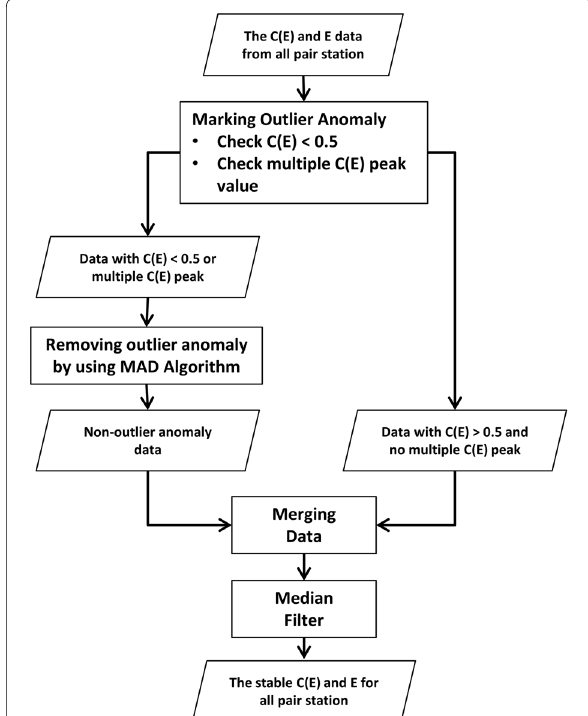
Fig. 4 Flowchart for detection and removal of unstable temporal velocity variations (outliers). Input data consist of the stretching coefficient C ( E ) and the temporal velocity changes E for each pair of stations. Given the threshold of C ( E ) and the tolerance coefficient TC of MAD, we can estimate the range of acceptable velocity variations by using Eqs. 5 and 6. If C ( E ) is outside that range, the velocity change is rejected. The final step is applying a median filter to obtain stable E